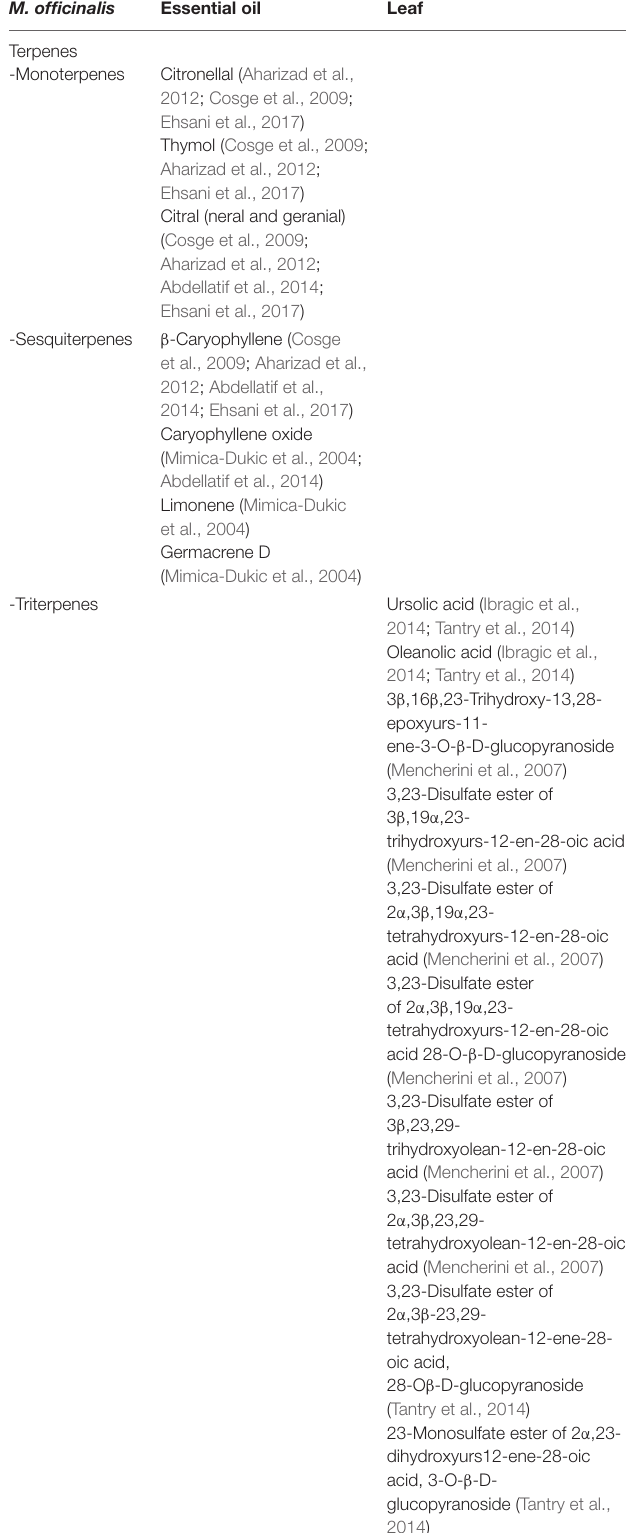
TABLE 1 | Major chemical constituents of M. officinalis essential oil and